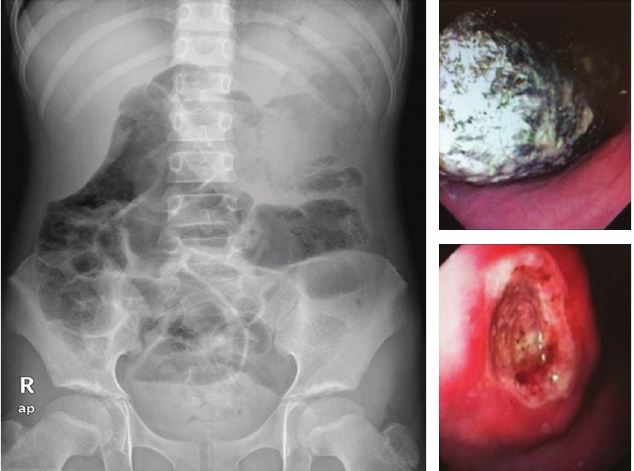
Figure 2: Dilated stomach and small bowel loops. A large trichobezoar and a gastric ulcer were visualized by